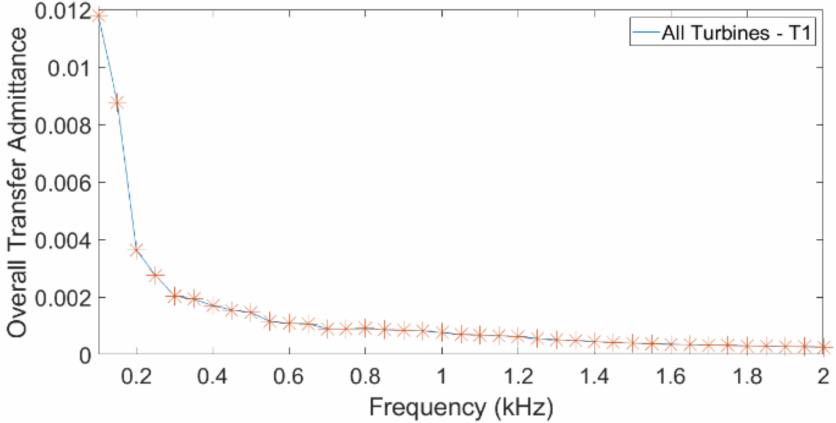
Figure 6. Overall transfer admittance (A/V) between turbines: 42-turbine